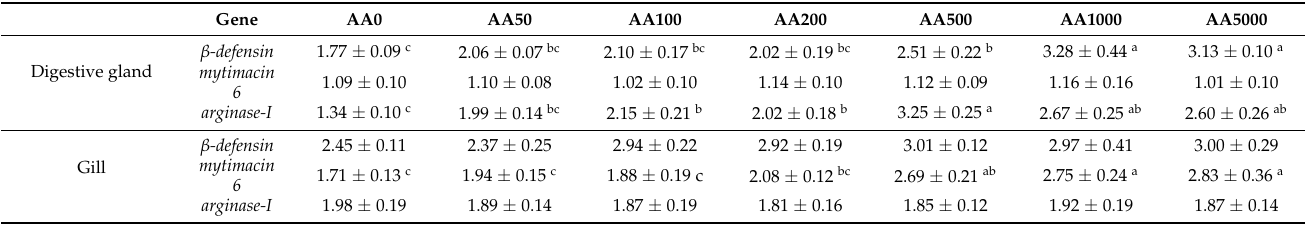
All data expressed as mean ± SE ( n = 3). Different lowercase letters in each row indicate significant differences ( p < 0.05).